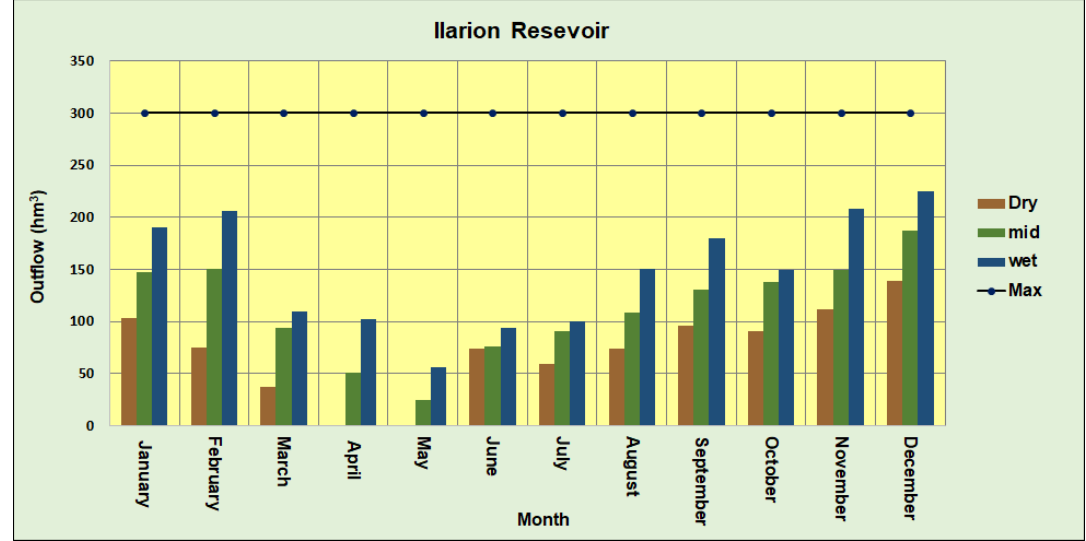
Figure 12. The optimal outflows for the current state of water resources demand, applying the institutional operating rule curves for the Ilarion reservoir.